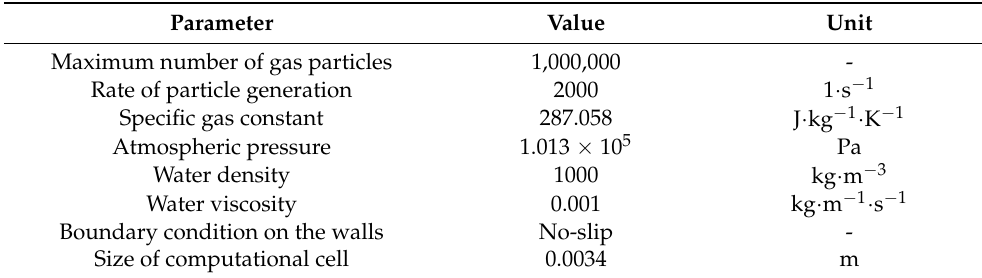
Table 1. Values of parameters used in the calculations.